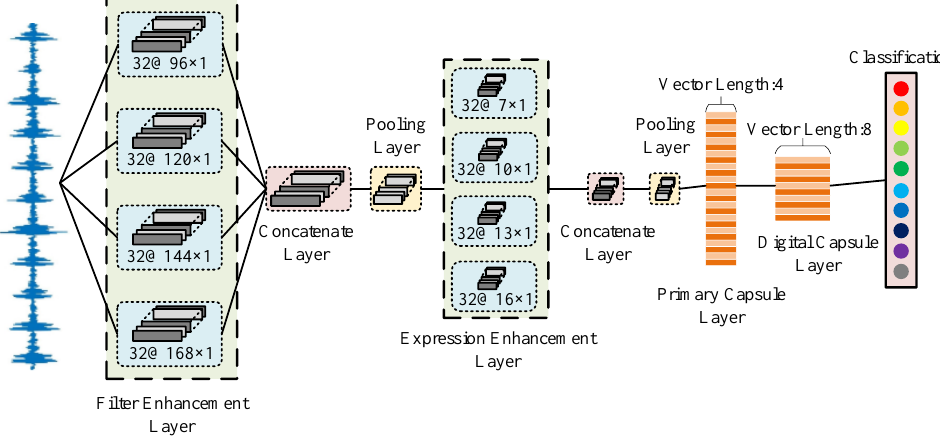
Figure 4. The structure of EIFN. The part in front of @ represents the number of channels, and the part behind @ indicates the size of the convolution kernel. See Section 4.2 for specific parameters.